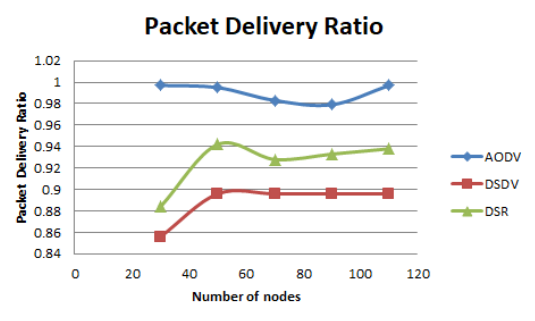
Table 21:- Packet Delivery